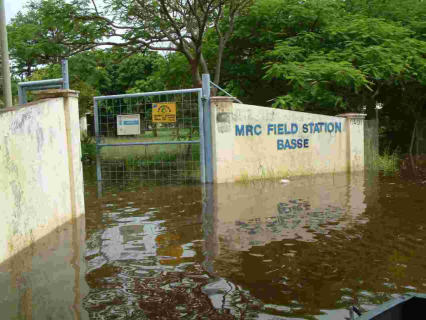
Main Gate into the MRC Field Station during the FloodsPhoto by Fred Yallop.